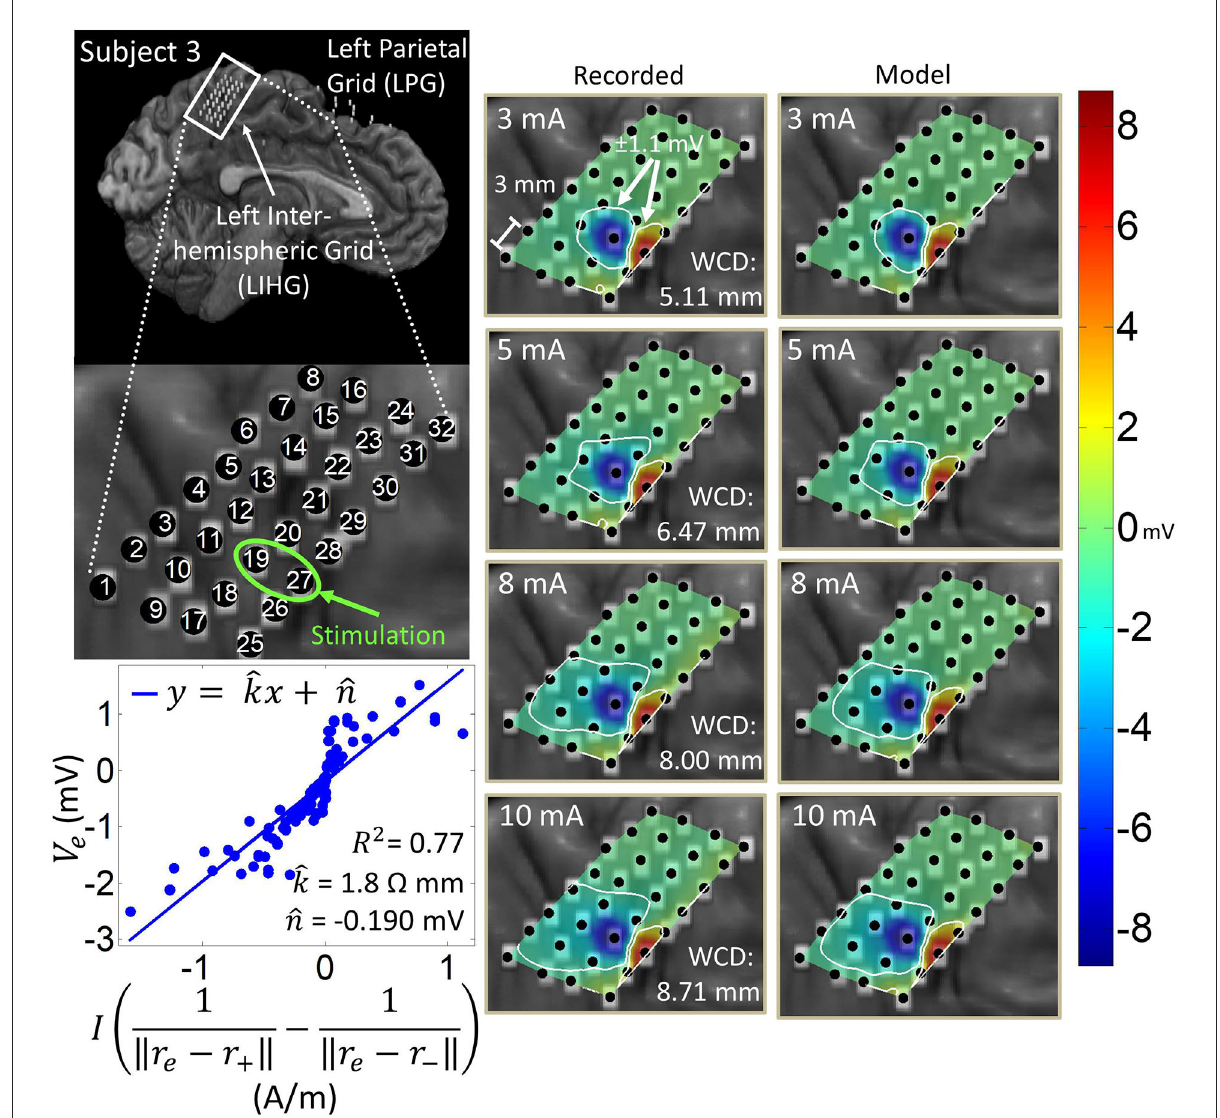
FIGURE7 Artifact spatial maps for recorded ECoG data and model predictions for subject 3. (Top left) Co-registration image showing the representative grid located over the leg area on the left side of the interhemispheric fissure. (Bottom left) Regression results for the stimulation